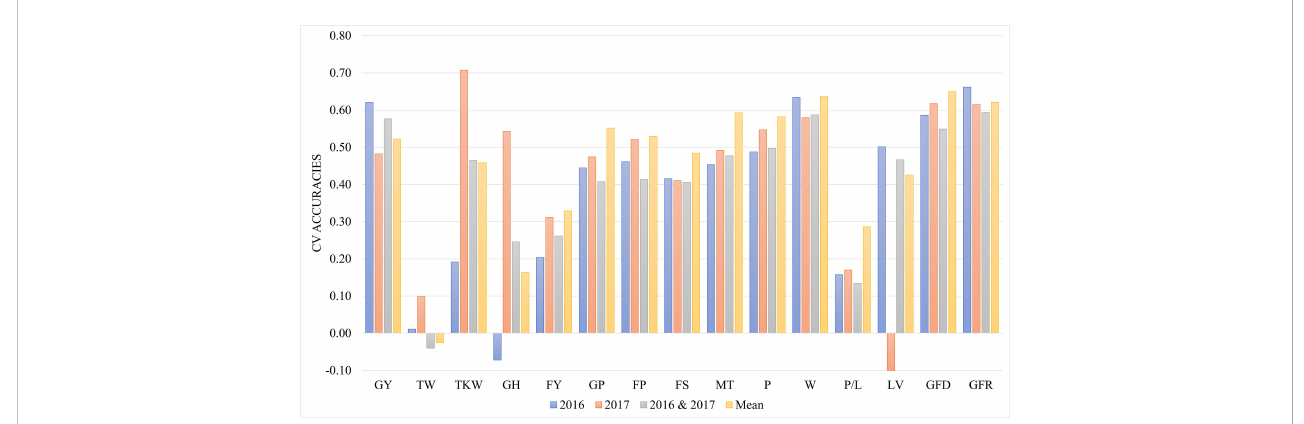
FIGURE 4 Genomic prediction accuracies using cross validation during 2016, 2017, joint 2016 and 2017 data, and mean across years. CV- Cross Validation; GY- Grain yield (t ha-1); TW, Test weight (kg hL,1); TKW, Thousand kernel weight (g); GH, Grain hardness; FY, Flour Yield (%); GP, Grain protein (%); FP, Flour Protein (%); FS, Sedimentation test (mL); MT, Mixing time of dough (min); P, Torque peak (%Torque*min); W, Elasticity or strength (J*10,4); P/L:, alveograph tenacity/extensibility ratio (P/L); LV, Loaf Volume(mL); GFD, Duration of grain fi lling (days); GFR, Rate of grain fi lling (mg